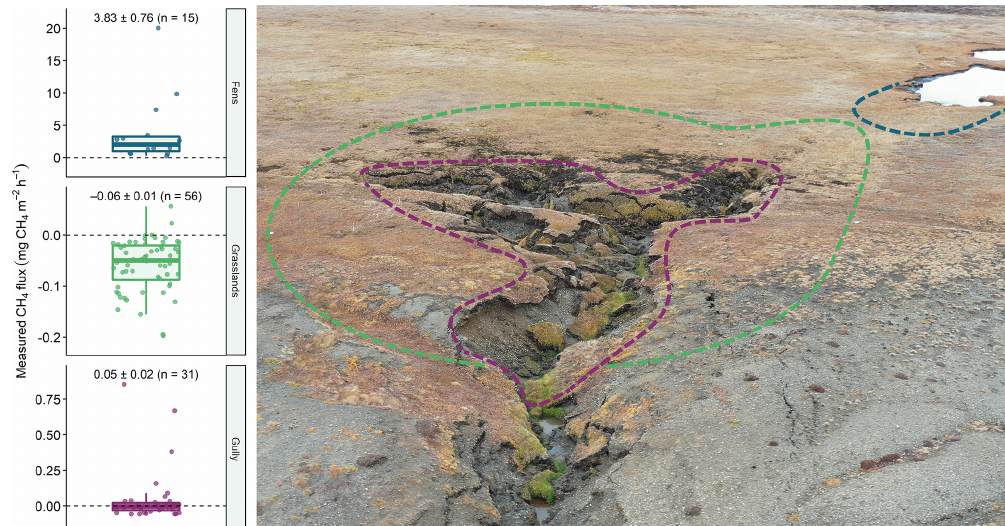
Figure 5. The gully and fen area near the Zackenberg Research Station. The three boxplots show the measured methane fluxes on different surface types between 23 August and 1 September 2019, when the image was captured. Dots on top of the boxplots show all the individual measurements. The dashed lines in the image indicate the approximate spatial extent of the measurements near the gully. The eroded area is ∼ 50m long and ∼ 25m at its widest, covering ∼ 720m 2